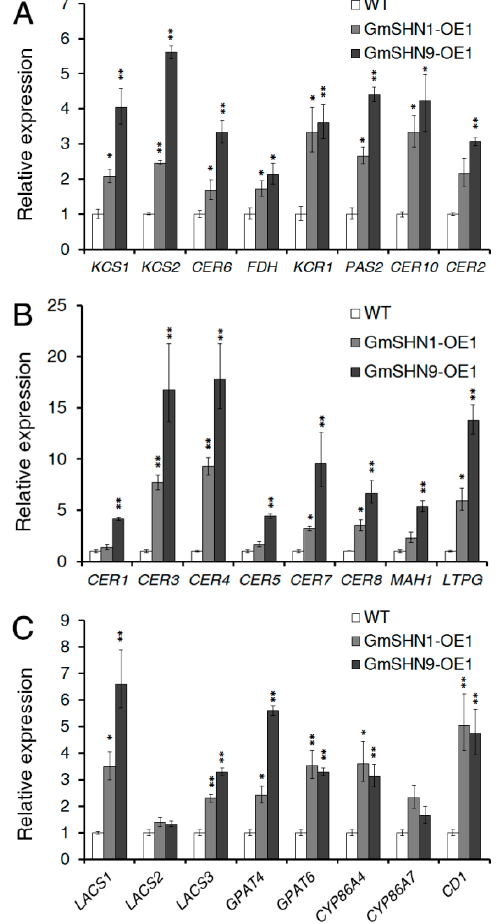
Figure 11. Expression of wax biosynthesis related genes in 6-week-old GmSHN1-OE1, GmSHN9-OE1, and WT Arabidopsis plants. ( A ) quantitative RT-PCR (qRT-PCR) analysis of the expression of genes involved in the fatty acid elongation process; ( B ) qRT-PCR analysis of the expression of genes involved in the biosynthesis of wax components; ( C ) qRT-PCR analysis of the expression of genes involved in the cutin biosynthesis pathway. Expression levels of each gene in WT were taken as 1. The Arabidopsis ACT2 gene was used as the internal control for normalization of the template cDNAs. The results are given as mean values of three replicates and error bars represent ±SD (* p < 0.05, ** p < 0.01 vs. WT with two tailed Student’s t test).